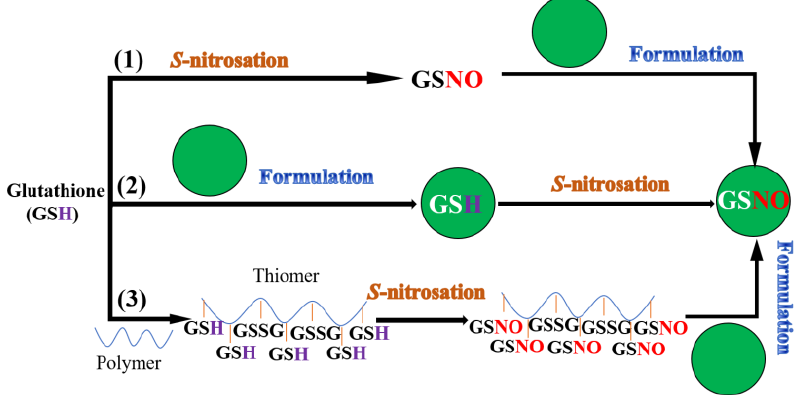
Figure 1. Schematic illustration of GSNO encapsulation strategies.